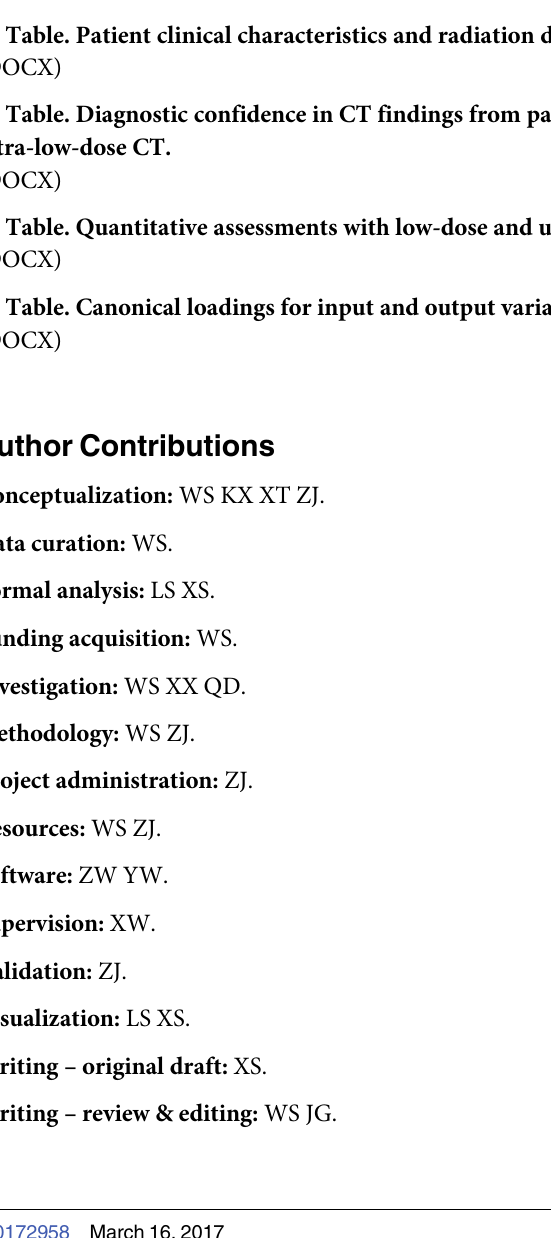
S1 Table. Patient clinical characteristics and radiation dose. S2 Table. Diagnostic confidence in CT findings from patients with PAP in LDCT and ultra-low-dose CT. S3 Table. Quantitative assessments with low-dose and ultra-low-dose CT. S4 Table. Canonical loadings for input and output variates for patients with